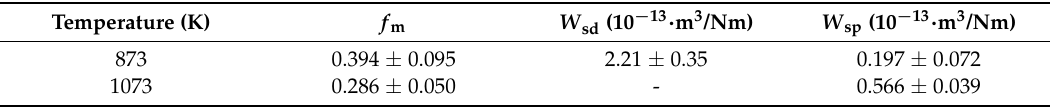
Table 1. Mean friction coefficient ( f m ), volume wear rate of the disk ( W sd ), and the pin ( W sp ) in TF550 alloy after wearing at high temperatures of 873 and 1073 K.